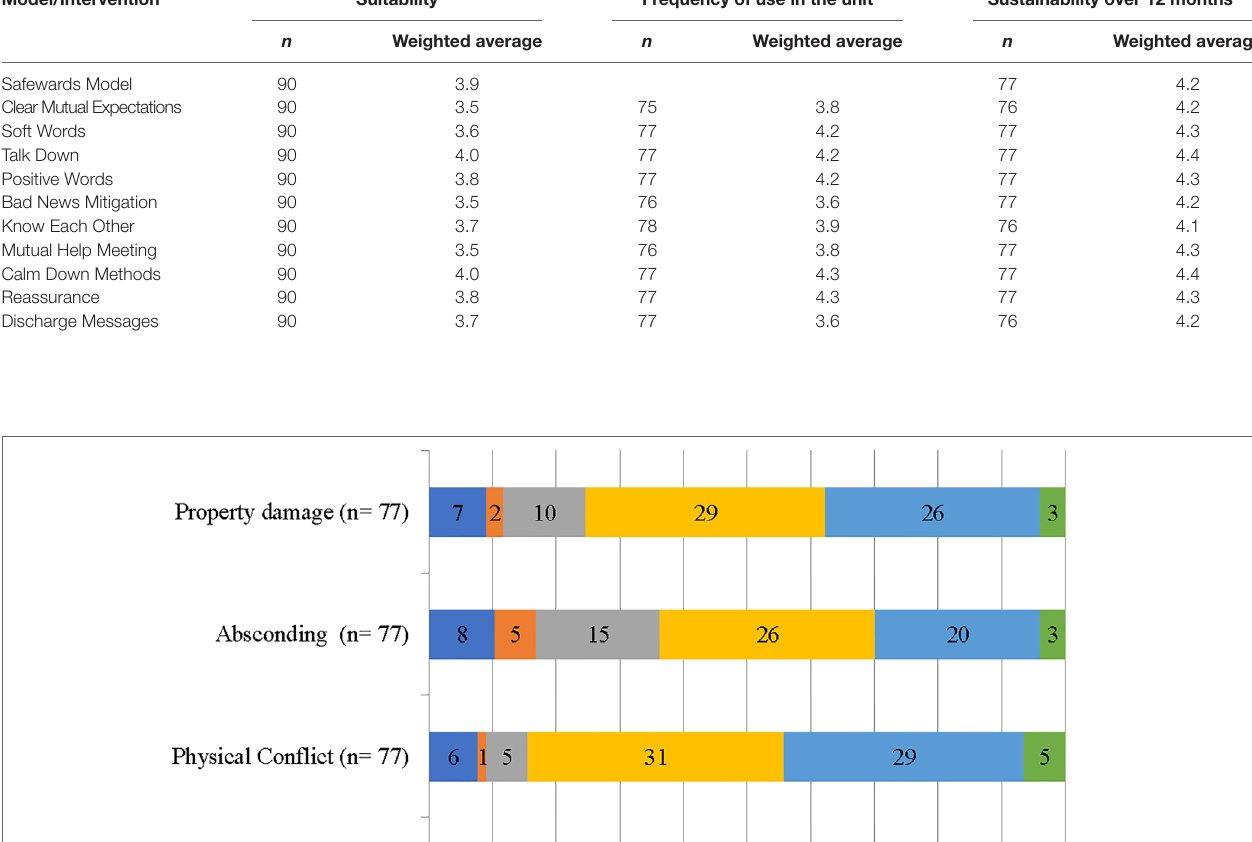
TABLE 3 | Suitability, use, and sustainability of Safewards model and interventions. Model/Intervention